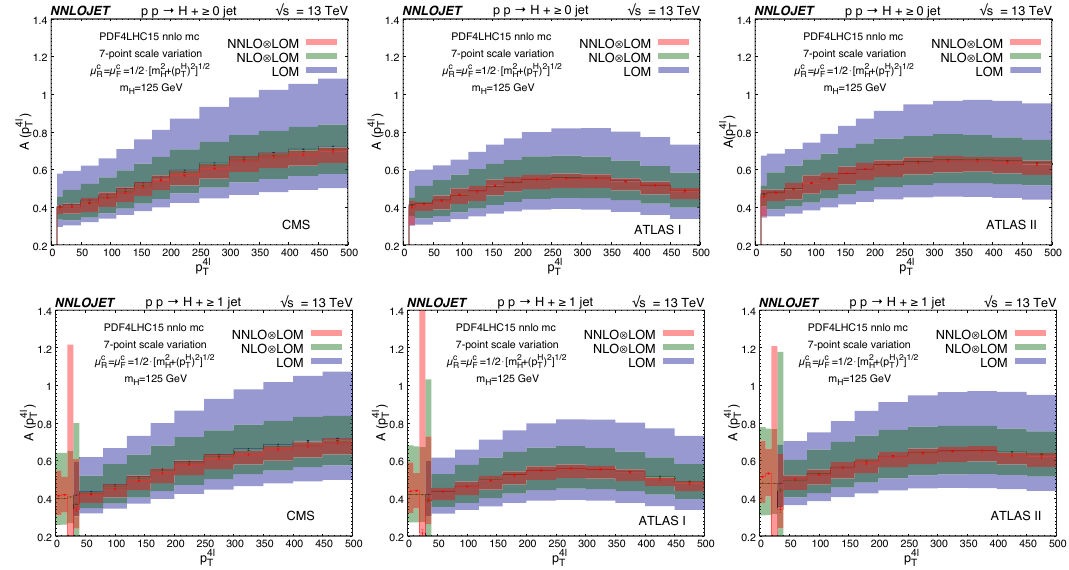
Figure 4. Acceptance of inclusive Higgs boson transverse momentum distributions for Higgs (upper) and Higgs-plus-jet (lower) production up to NNLO for CMS (left), ATLAS I (centre) and ATLAS II (right)